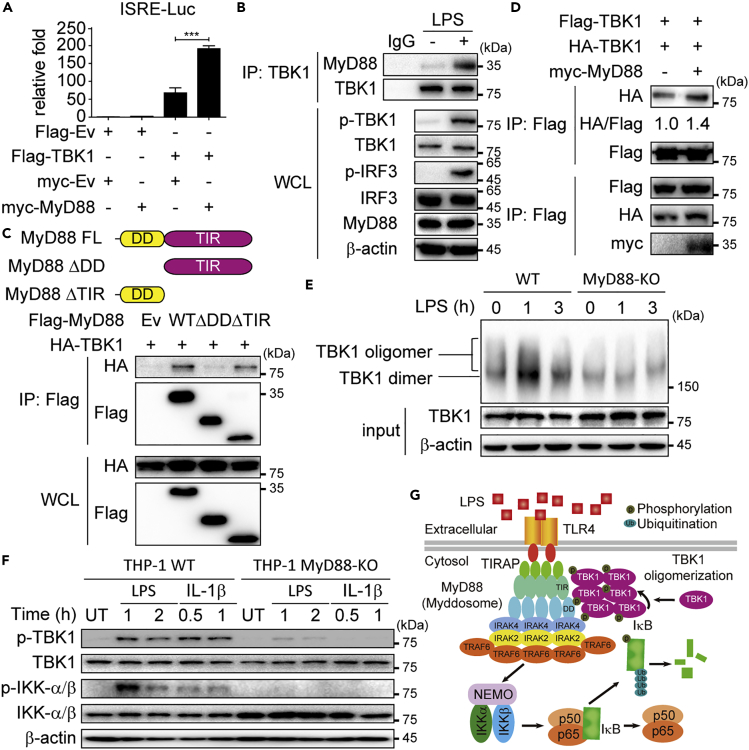
MyD88 Activates TBK1 through TIR Domain(A) HEK 293T cells were transfected with plasmids encoding ISRE luciferase reporter and Flag-TBK1, together with expression vector for myc-MyD88 or empty vector (Ev).(B) Co-immunoprecipitation (IP) and immunoblot (IB) analyses were performed for THP-1-derived macrophages stimulated with LPS (200 ng/mL) for 1 h with indicated antibodies.(C) HEK 293T cells transfected with HA-TBK1 and its deletion mutants. Whole-cell lysates (WCL) were immunoprecipitated with anti-Flag beads, followed by IB analyses with anti-HA antibody. HEK 293T cells were transfected with Flag-TBK1 and HA-TBK1, together with empty vector and myc-MyD88.(D) Cell lysates were collected for IP with anti-Flag beads followed by IB analyses with anti-HA antibody.(E) Native gel electrophoresis assay of TBK1 oligomerization in wild-type (WT) and MyD88-knockout (KO) THP-1-derived macrophages under LPS stimulation (200 ng/mL) for indicated time points.(F) IB analysis of total and phosphorylated TBK1 and IKK-α/β in WT and MyD88-KO THP-1-derived macrophages stimulated with LPS (200 ng/mL) or IL-1β (10 ng/mL) or left untreated (UT).(G) Proposed model illustrating how TBK1 is activated by MyD88 under LPS stimulation.Data are representative of three independent biological experiments (shown as mean ± SEM in [A]), *** p < 0.001.